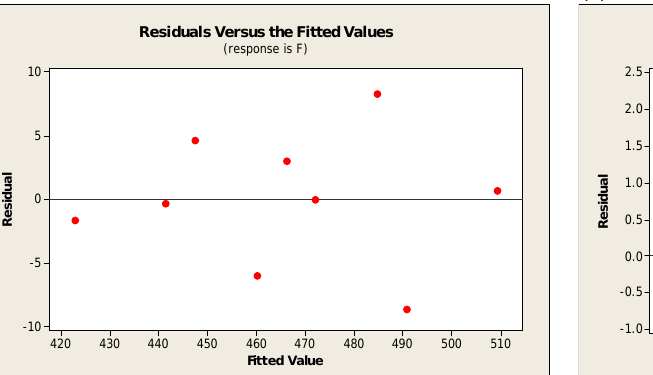
Fig. 3. Normal probability plot of residuals for cutting force (F) Fig. 4. Normal probability plot of residuals for cutting temperature (T)